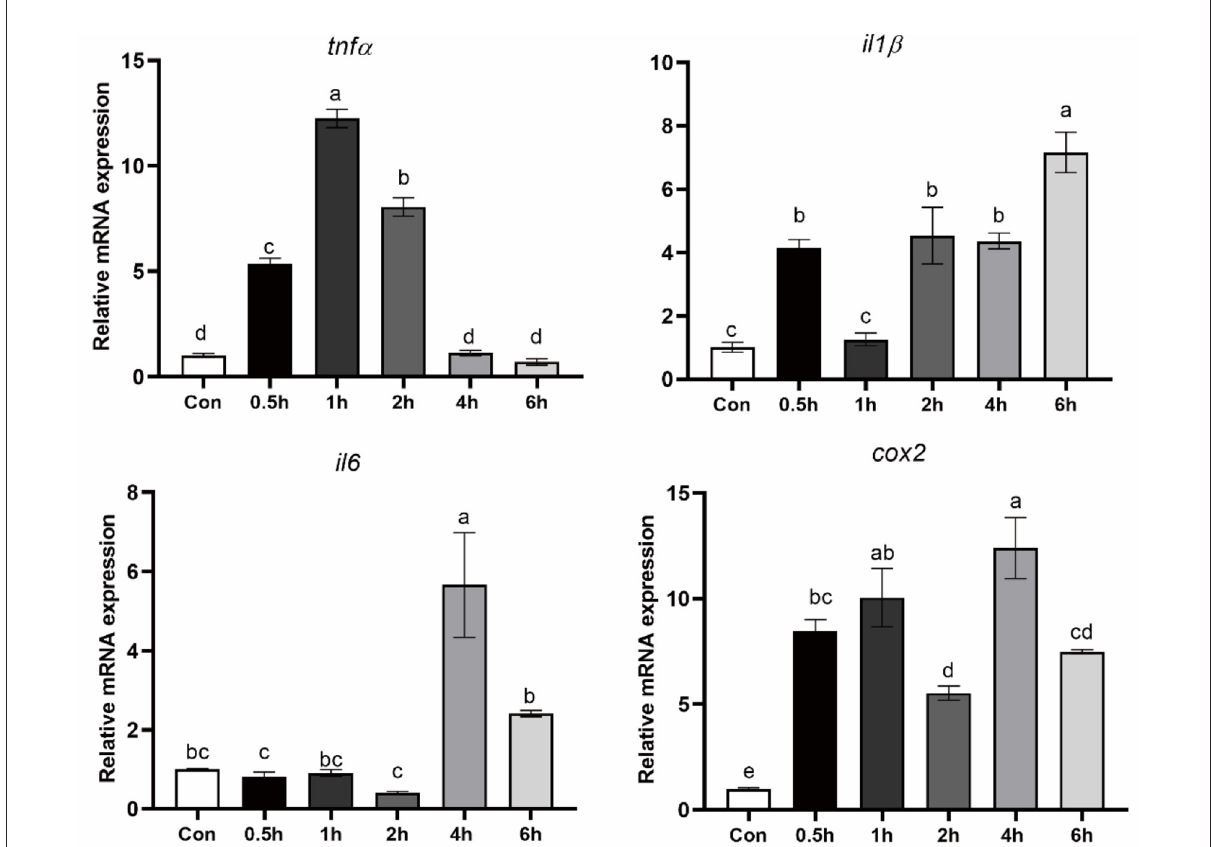
FIGURE3 Expression of pro-inflammatory genes in croaker macrophages after treatment with TM. The significance was analyzed by one-factor ANOVA and Duncan’s Multiple Range Test (means ± SEMs; n = 3). Means without the same label were considered different, P < 0.05.